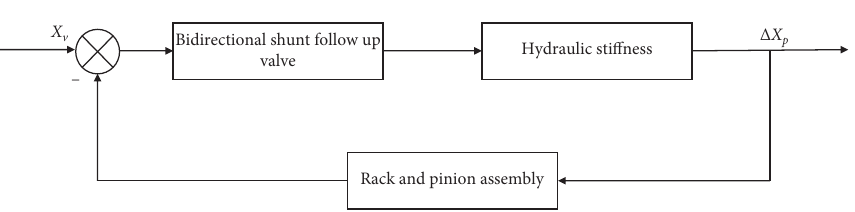
Figure 8: Block diagram of the hydraulic control system.